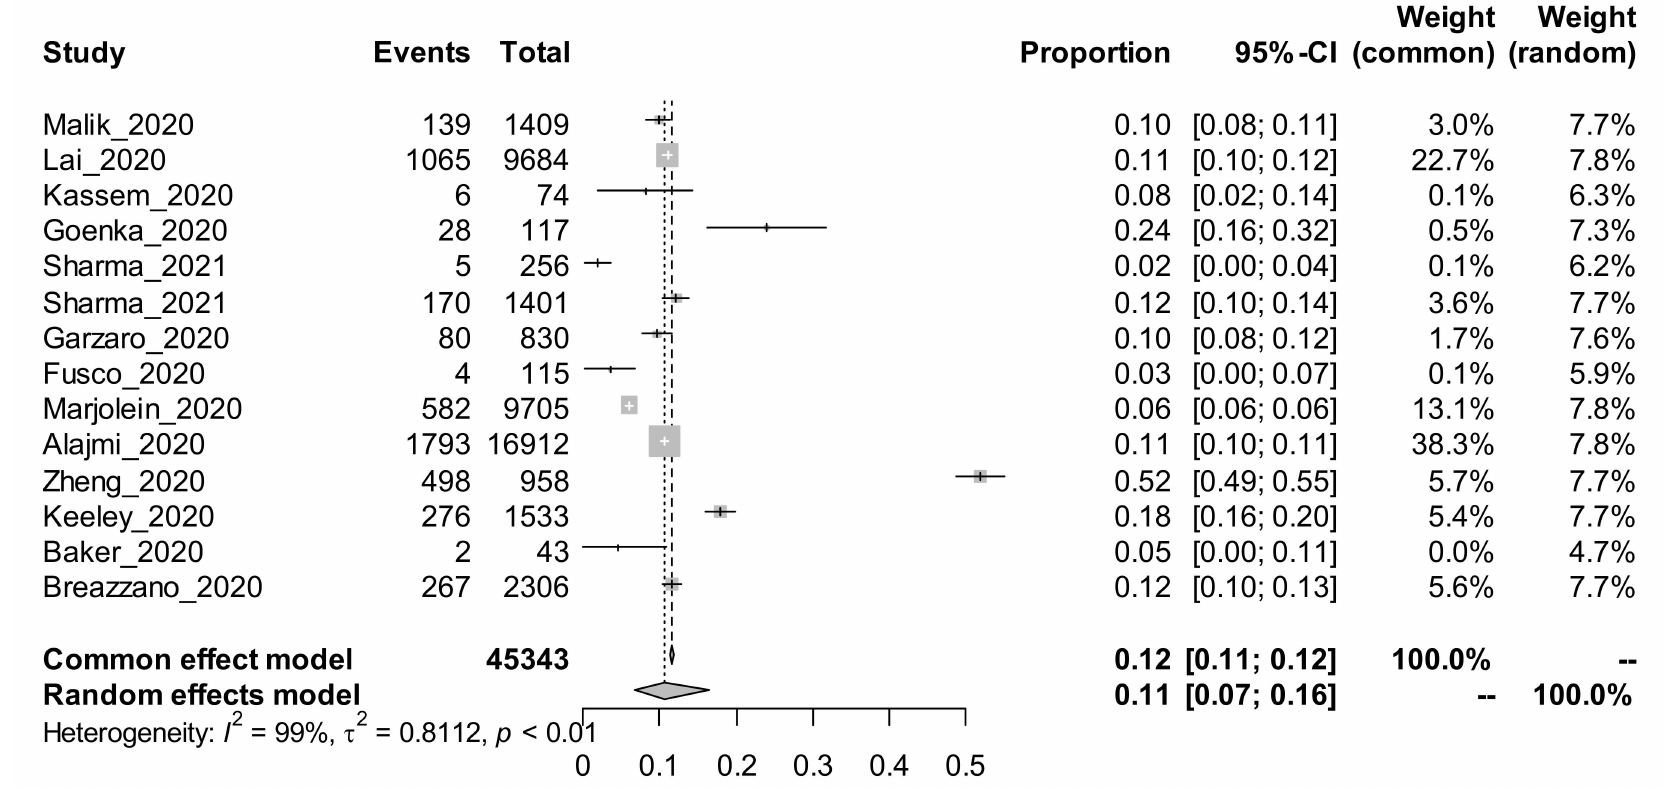
Figure 2. Forest plot showing the prevalence of COVID-19 among studies using the PCR method of